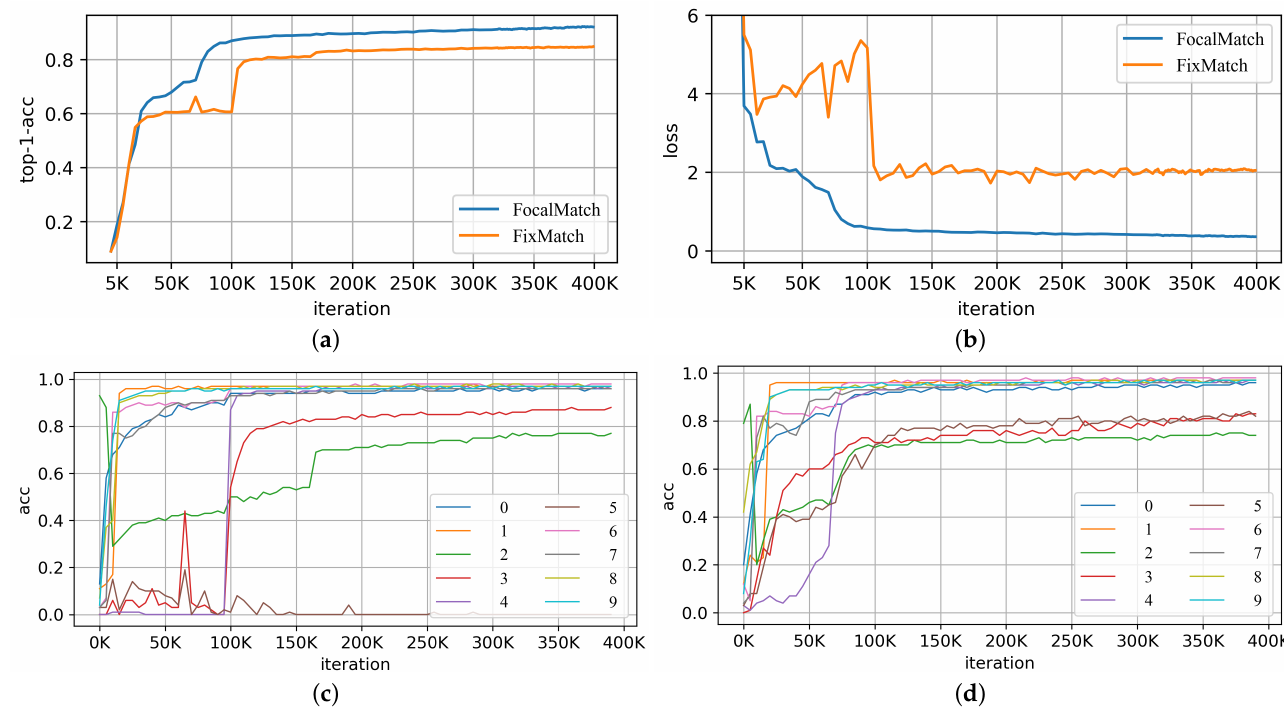
Figure 3. The comparison of accuarcy and loss between FixMatch and FocalMatch on CIFAR-10 dataset. The numbers in legends of ( c , d ) represent the 10 classes in CIFAR-10 dataset. ( a ) top1 accuracy. ( b ) loss. ( c ) Accuracy for each class of FixMatch. ( d ) Accuracy for each class of